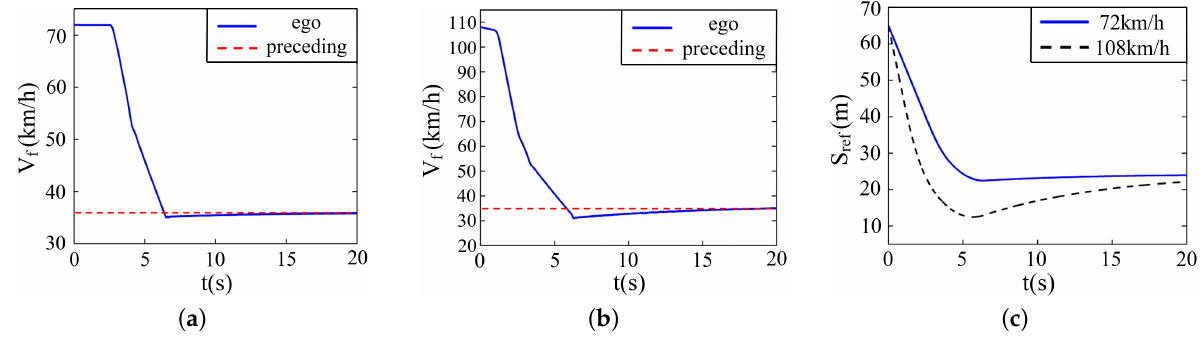
Figure 12. Simulation on straight roads when preceding vehicle drives at a constant speed. ( a ) Velocity (72 km/h). ( b ) Velocity (108 km/h). ( c ) Relative